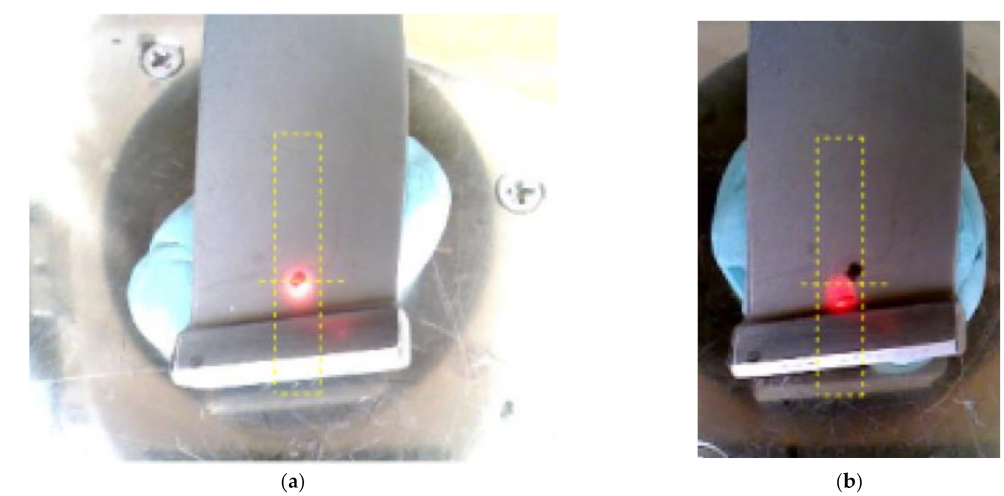
Figure 4. Measurement of residual/initial stresses on the blade surface, at a distance of h = 3 mm ( a ) and h = 1 mm ( b ) from the blade